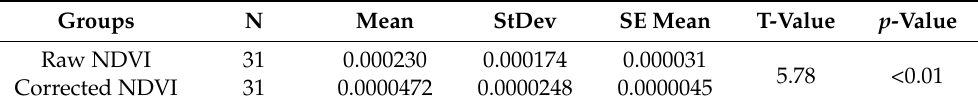
Figure 7. Two-sample t -test between the variance of daily NDVI for the sample dataset (G1H) before and after ANN model correction. Table 5. The results of the two-sample t -test between the variance of daily NDVI before and after ANN model correction.